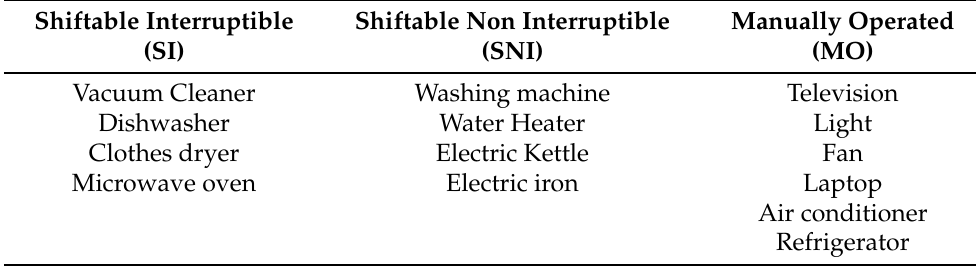
Table 3. Classification of